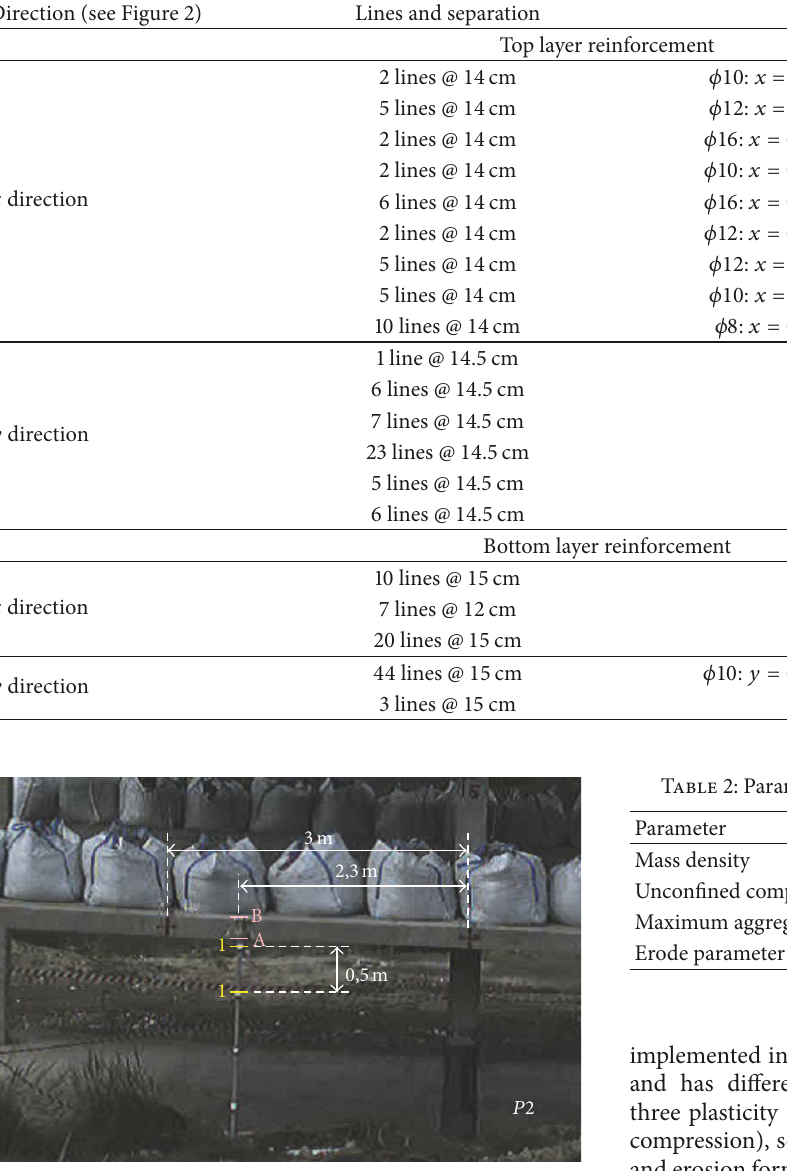
Figure 3: Picture of the points of measure in the slab. 𝑃2 is the half of the column before it was removed.